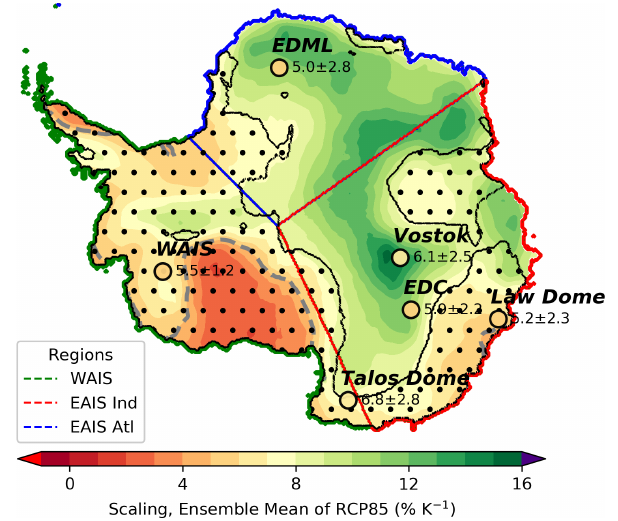
Figure 4. CMIP5 data set mean of the temperature-scaled precip- itation for the period from 2051 to 2100. This scaling under the RCP8.5 scenario comes from nine CMIP5 models (Table 1), which are driven by anomalies relative to the first 50 years of piCon- trol. In the dotted regions enclosed by black contours, the com- bined simulated scaling and the standard deviation contain the value of 5%K − 1 . Gray dashed lines follow this 5%K − 1 contour. The scaling values deduced from ice cores are shown at their location (Frieler et al., 2015) using the same color bar as the spatial dis- tribution within the circle. The neighboring printed values are the mean and the 2 σ uncertainty. Three defined regions (Table 5) named “WAIS”, “EAIS Atl”, and “EAIS Ind” are outlined using green, blue, and red boundaries (lower left legend), respectively. For fur- ther details, the reader is referred to Sect. 3.2. Figure E3 provides the corresponding distributions for each CMIP5 model. Antarctica’s contour is deduced from Fretwell et al. (2013).